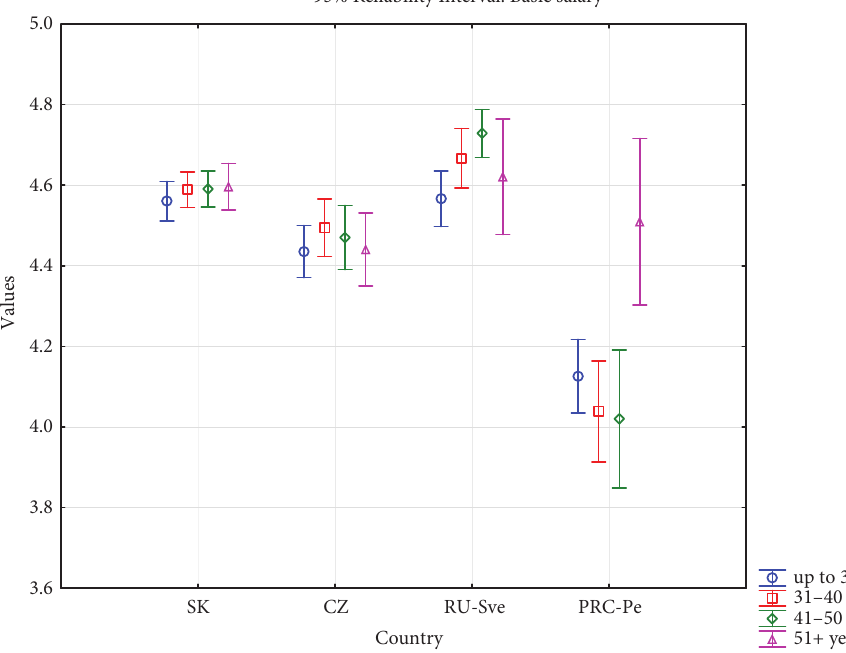
Figure 2. “Basic salary” interactions and age